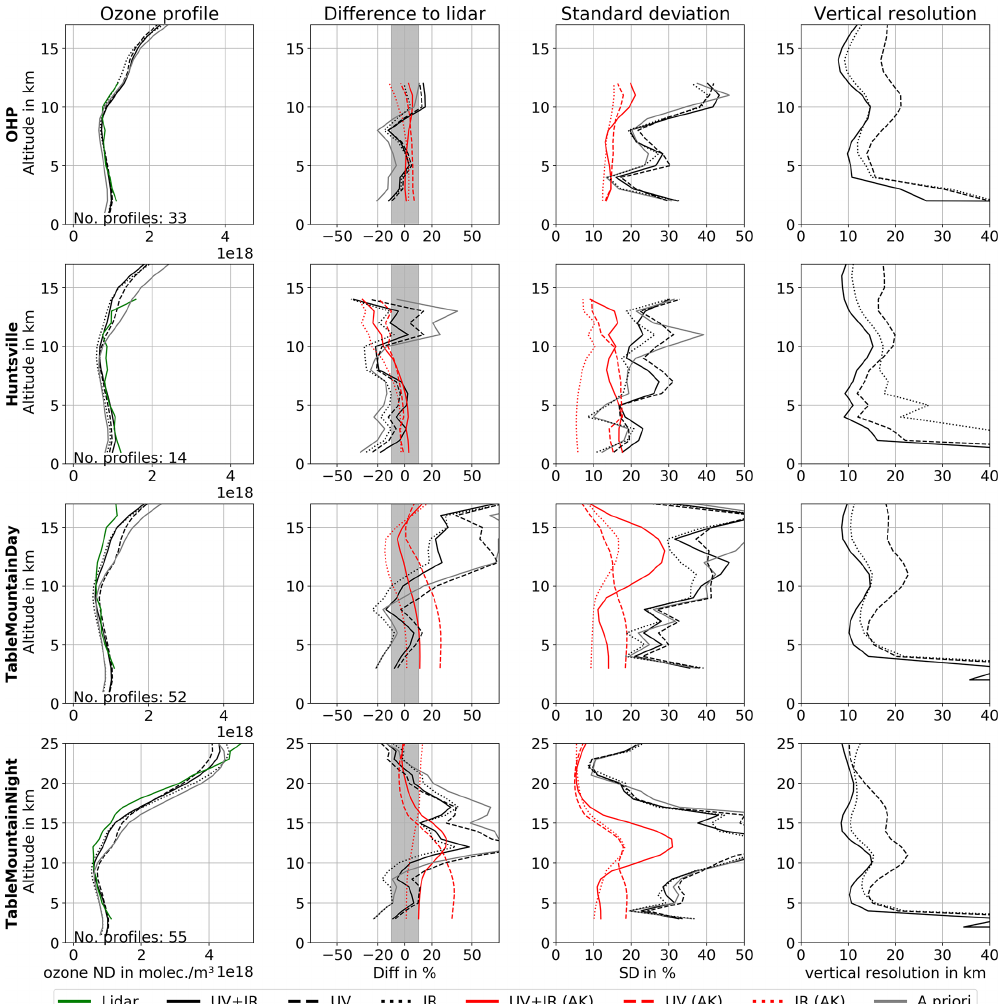
Figure 5. Ozone profile comparison between UV + IR, UV-only, and IR-only retrievals and tropospheric ozone lidar measurements from three different sites. Table Mountain provides daytime (matching S5P/CrIS overpasses) profiles in addition. Nighttime profiles can reach a height of up to 28km and are used for comparison up to 25km. In the panel showing the difference, the grey shaded area marks the ± 10%